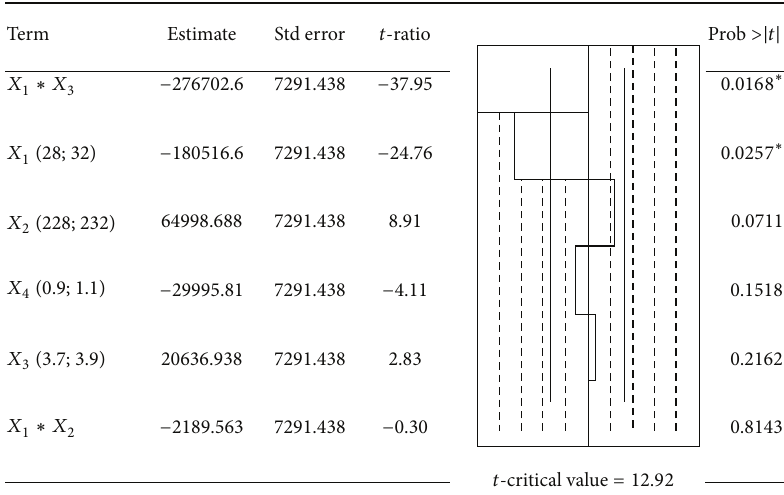
Figure 3: Pareto chart showing the effects of HPLC parameters on the chromatographic peak area. Table 4: Determination of the percent encapsulation efficiency (EE%, ± SD) in USP tablet and FUR-loaded nanocarriers ( 𝑛 = 3 ). Percent of theoretical drug amount